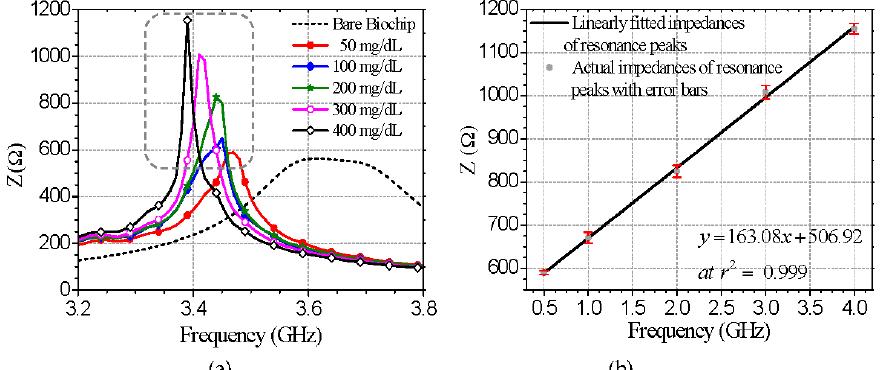
Figure 5. Microwave-impedance spectroscopy-based label-free detection of glucose in deionized water and D -glucose powder solutions. ( a ) Glucose-level dependent characteristic impedances of the proposed glucose biosensor for glucose-water solutions of varying glucose concentrations (50–400 mg/dL). ( b ) Linearly fitted impedances of the resonance peaks, including actual impedances of the peaks and error bars represented by RSDs of six independent measurements